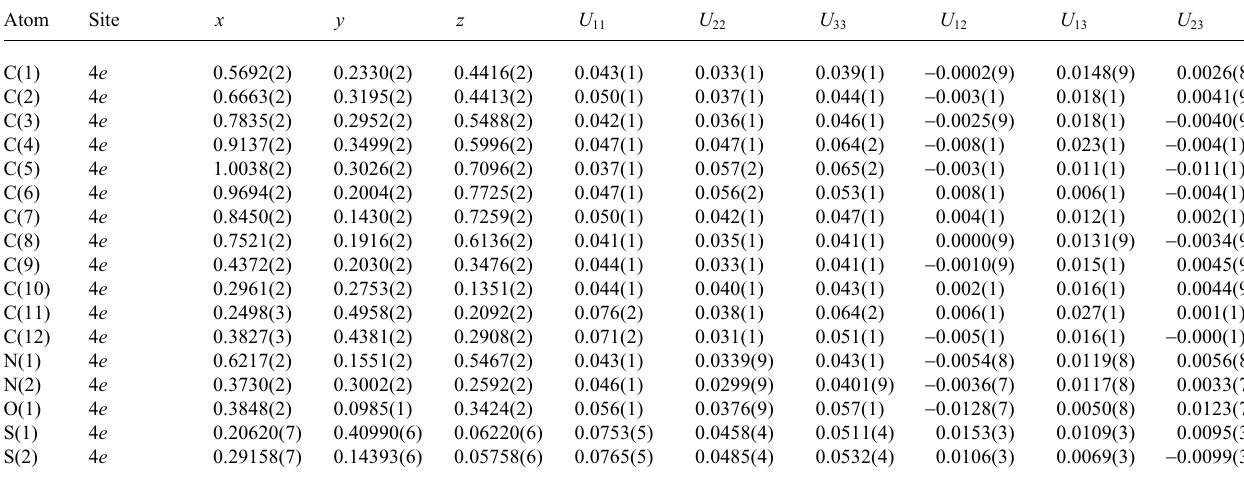
Table 3. Atomic coordinates and displacement parameters (in Å 2 )